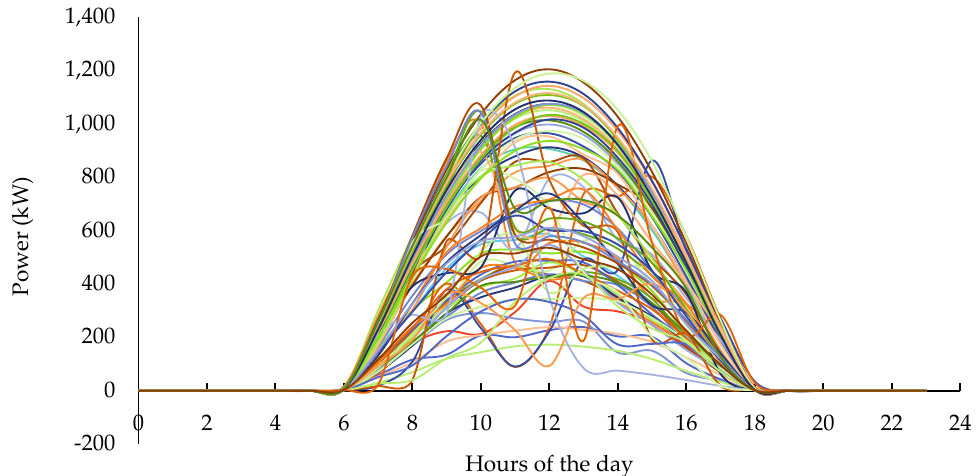
Figure 12. Daily generation data over a year of the photovoltaic solar power plant. Table 2. Summary of simulated parameters for photovoltaic solar